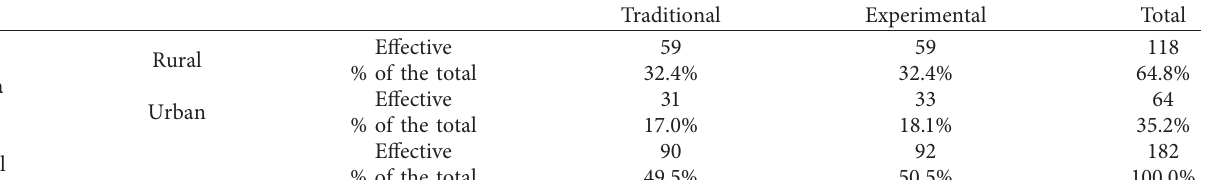
Table 2: Distribution of students by the study area and method